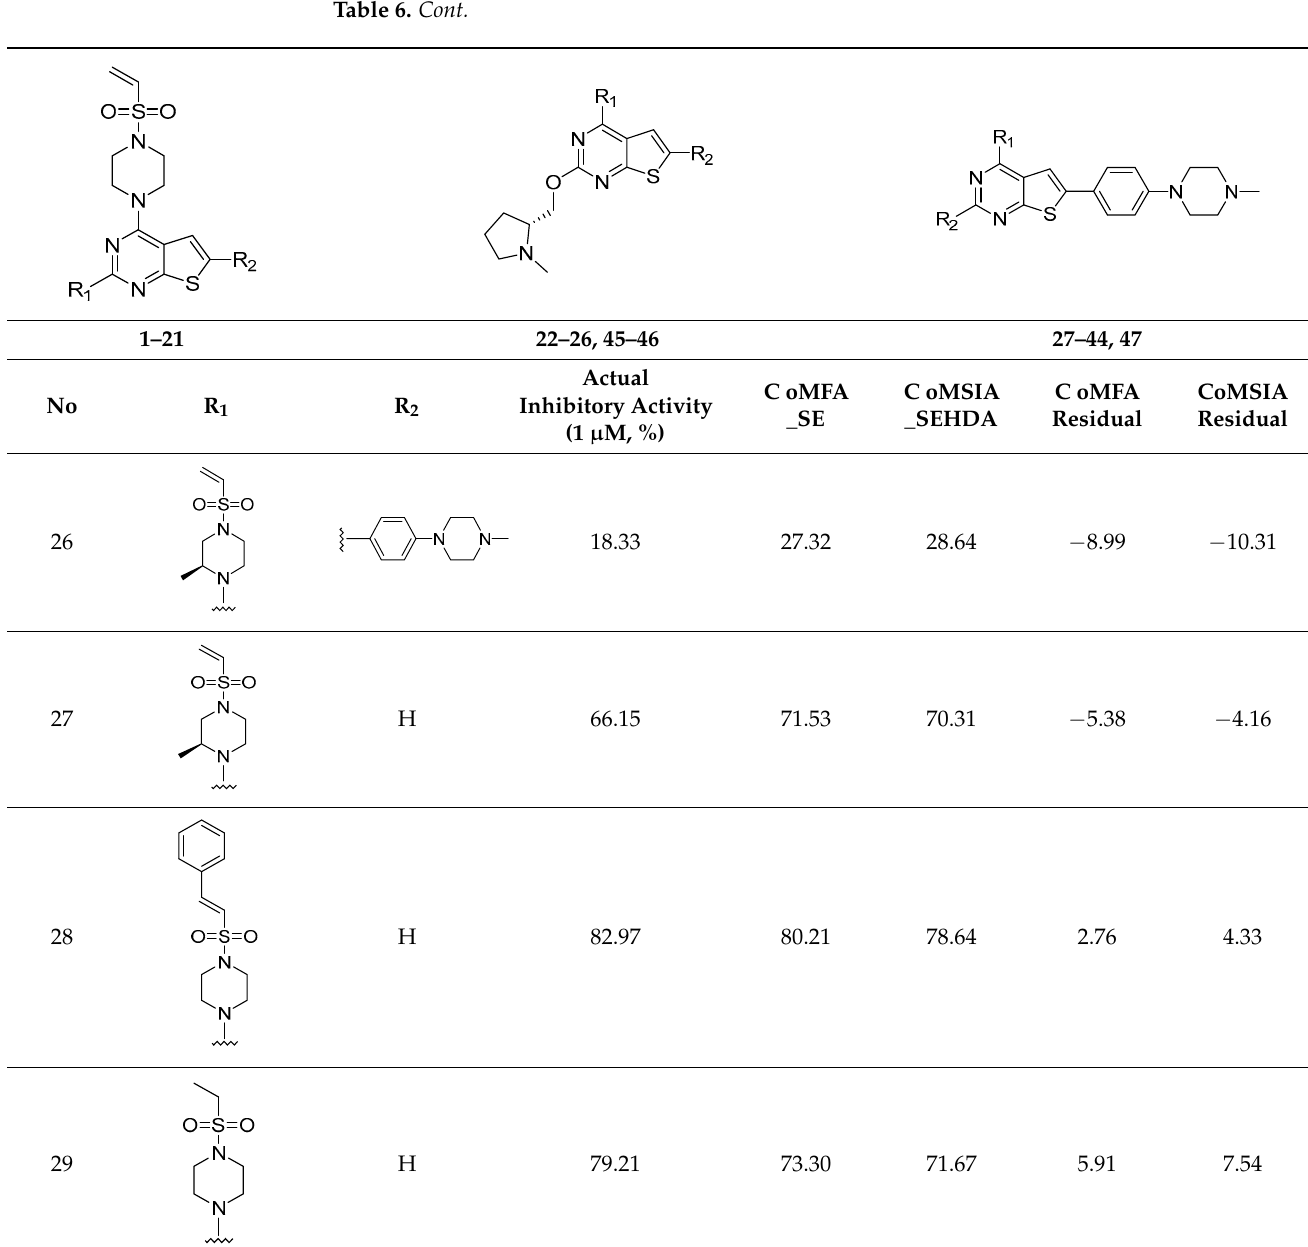
Table 6. Chemical structures and inhibitory activity values of thieno-pyrimidine derivatives. Table 6. Cont.